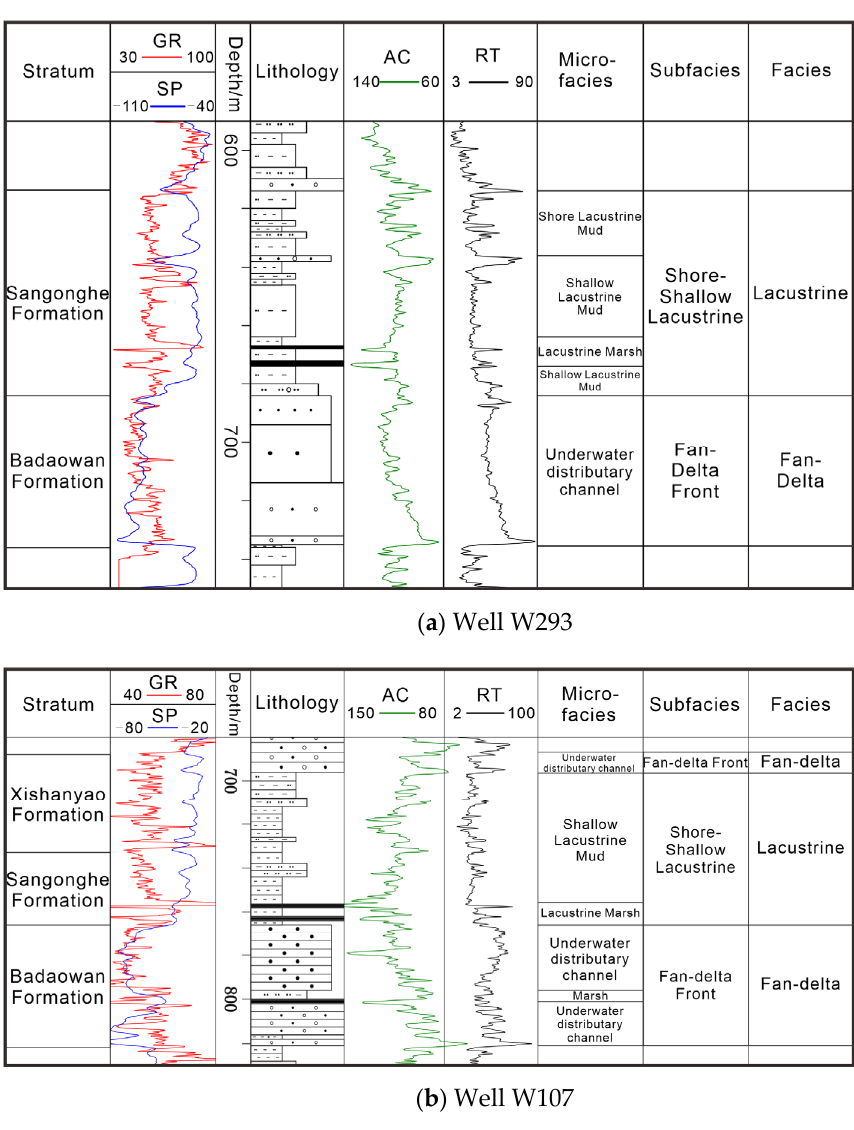
Figure 5. Single-well logging facies analysis of Well W293 and Well W107, ( a ) Well W293, ( b ) Well W107.